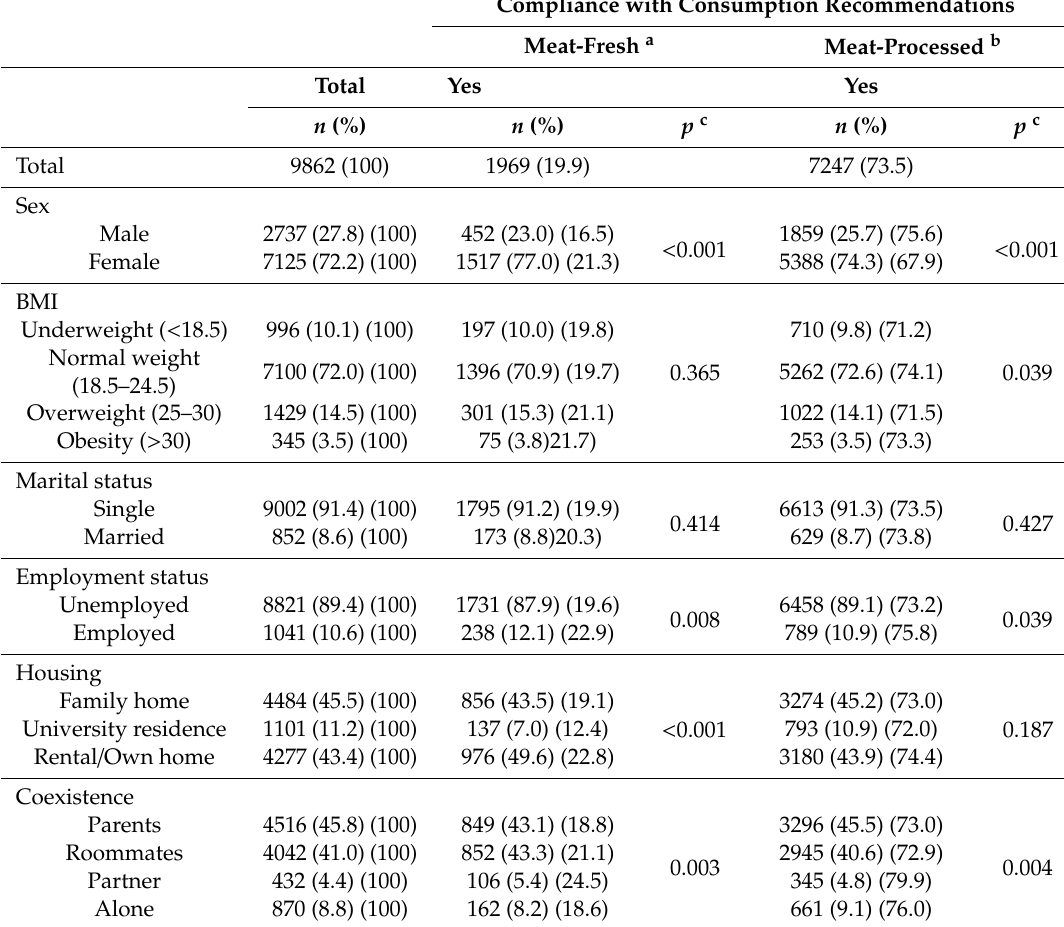
Table 3. Compliance with recommendations on the frequency of meat consumption according to personal and sociodemographic characteristics of the university